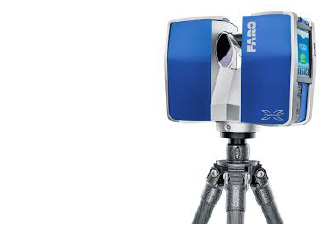
Figure 2. Characteristics and photograph of the Faro (cid:114) Focus 3D X330